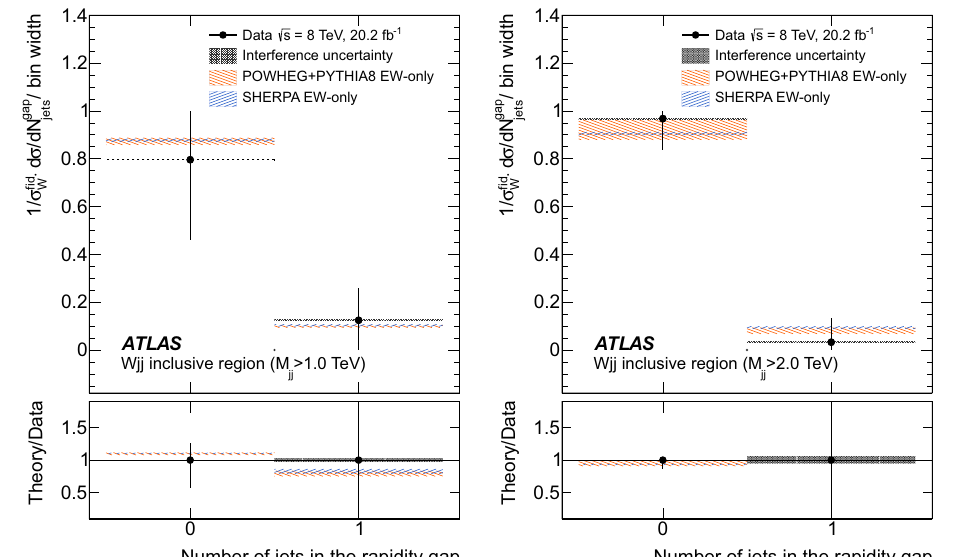
Fig. 21 Unfolded normalized differential EW W jj production cross sections as a function of the number of jets with p T > 30 GeV in the rapidity interval bounded by the two highest- p T jets in the inclusive fiducial region, with M jj > 1 . 0 TeV ( left ) and M jj > 2 . 0 TeV ( right ).